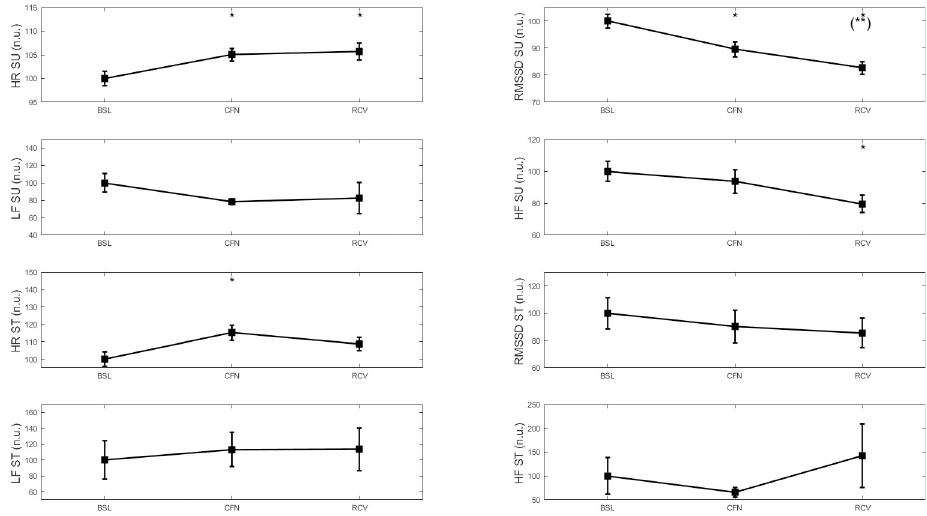
Fig 1. HR, RMSSD, LF and HF before (BSL), during (CFN) and after (RCV) the strict lockdown period in France in 76 participants who deteriorated or maintained their well-being over the CFN period. SU: supine position, ST: standing position. � p < 0.05, �� p < 0.01 for difference with BSL. # p < 0.05 for difference with